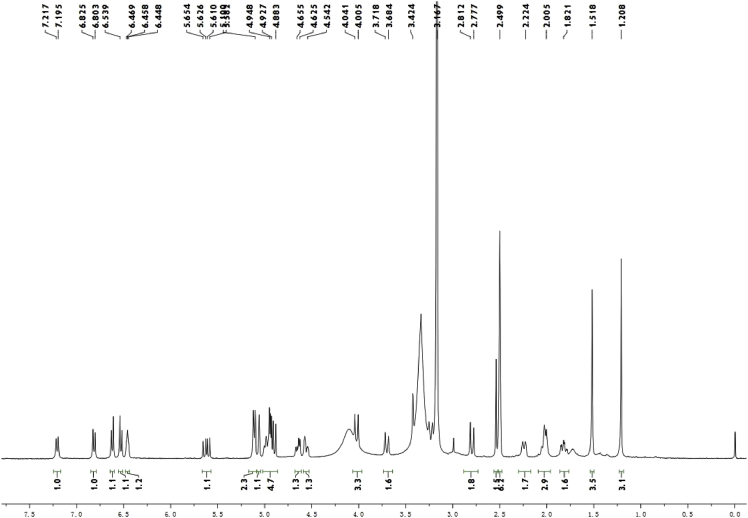
1H-NMR spectrum of meroterpenoid 8.